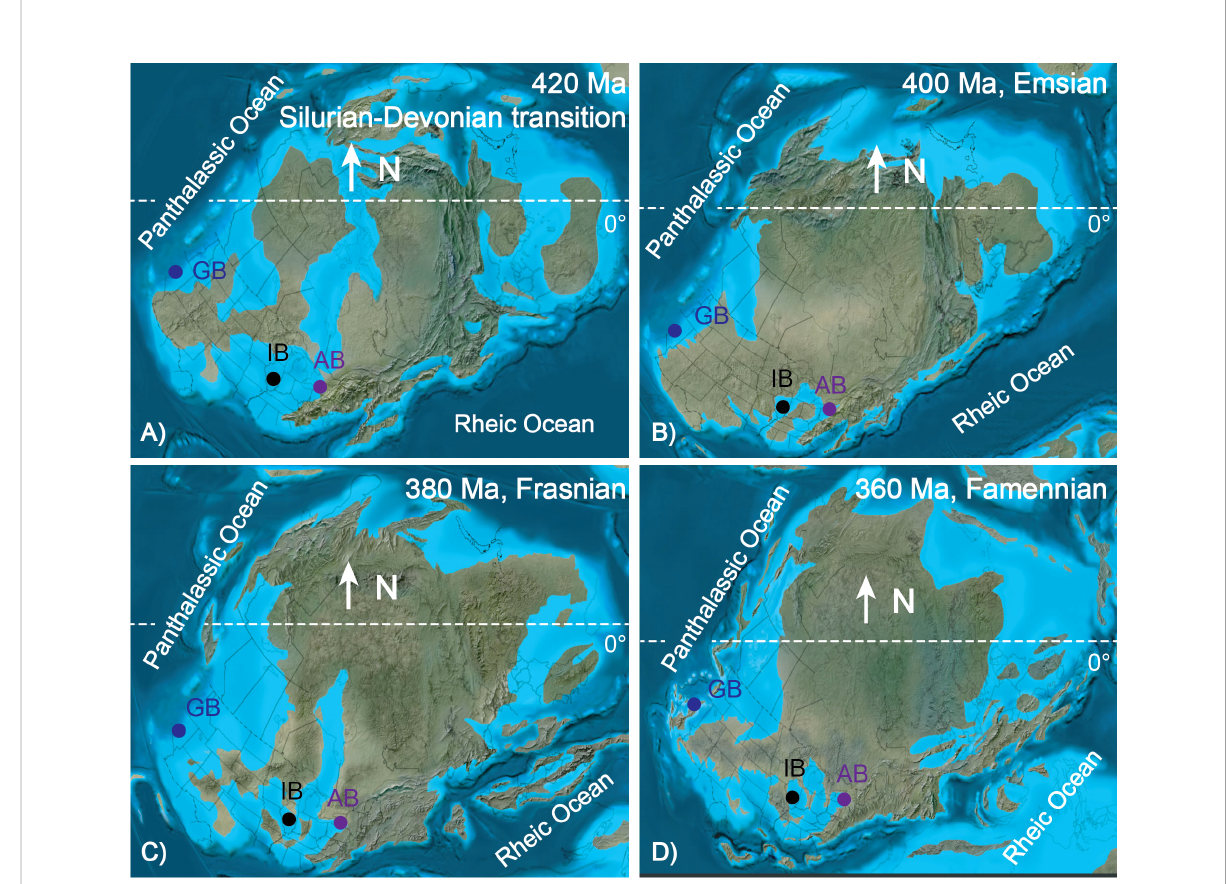
FIGURE 1 Paleogeographic maps of Laurussia during different stages (A – D) of Devonian. Maps are based on Blakey (2018). Dashed white lines represent the paleo-equator. GB represents the location of Great Basin composite section. IB represents the location of Illinois State Geological Survey White County Core of Illinois Basin. AB represents the location of the Middle Devonian core from the Appalachian Basin (He et al.,